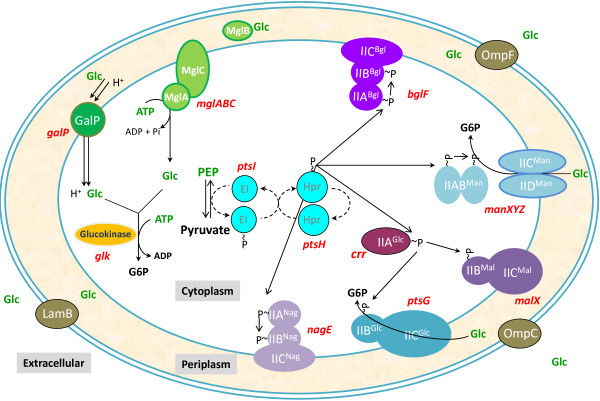
Proteins involved in glucose transport and phosphorylation in E. coli. EI, enzyme I; HPr, phosphohistidine carrier protein; IICBGlc, integral membrane glucose permease; IIABCBgl, components of the beta-glucoside PTS complex; IIABMan and IICDMan components of the mannose PTS complex; IIBCMal, components of the maltose PTS complex; IIABCNag, components of the N-acetylglucosamine PTS complex; GalP, galactose:H+ symporter; MglA, MglB and MglC, components of the galactose/glucose high-affinity ABC transporter; LamB, OmpF and OmpC, outer membrane proteins.